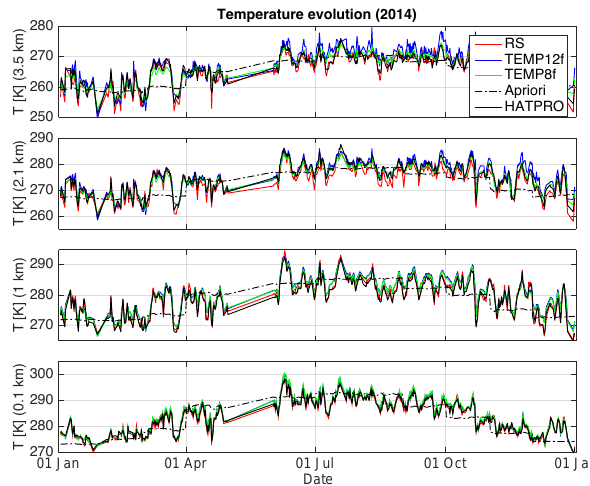
Figure 6. Temperature evolution at different altitudes for RSs, HAT- PRO and TEMPERA (inversions with 8 and 12 filters), and the a priori temperature used for TEMPERA